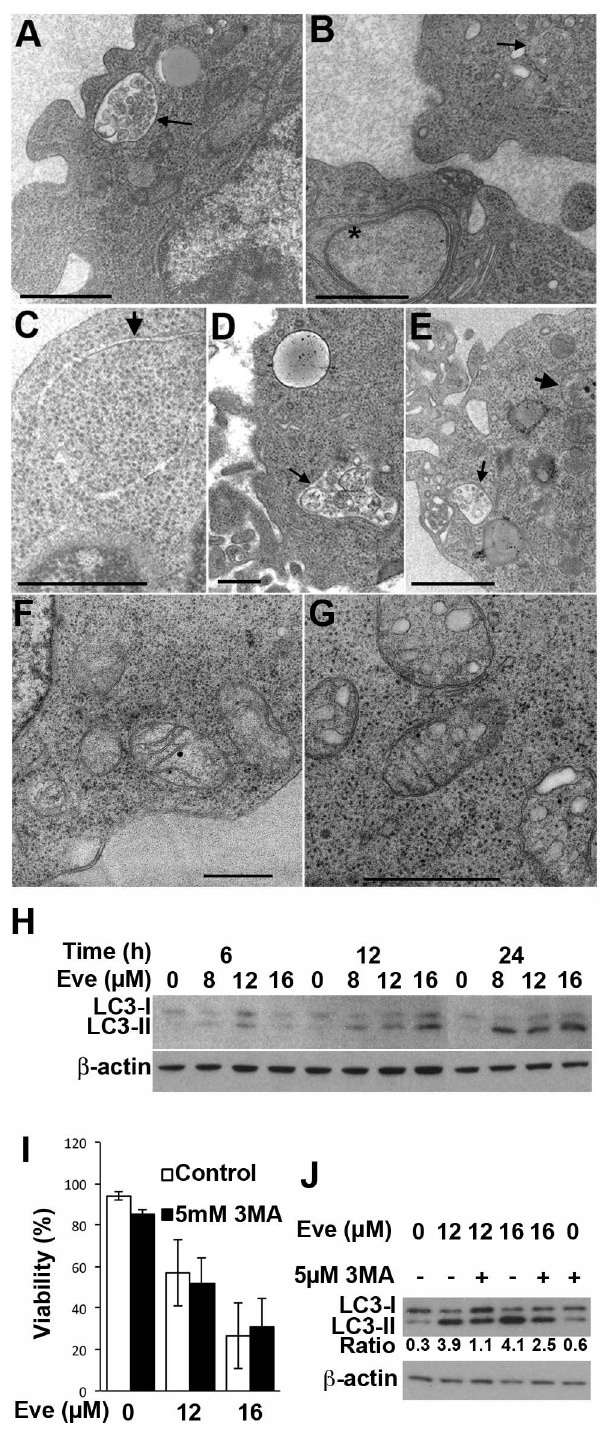
Figure 3. Everolimus-Induced Autophagy is Not Required for Cell Death. ( A–G ) NALM6 cells were treated with vehicle or 16 m M everolimus overnight and ultrastructure examined by electron micros- copy. Fine arrows indicate autophagic vacuoles containing degrading organelles. Thick arrows indicate stretches of double membrane walling off regions of cytoplasm. Scale bars indicate 100 nm. ( H ) Cell lysates prepared from NALM6 cells cultured for the indicated time periods with the specified concentration of everolimus were analyzed for LC3-I